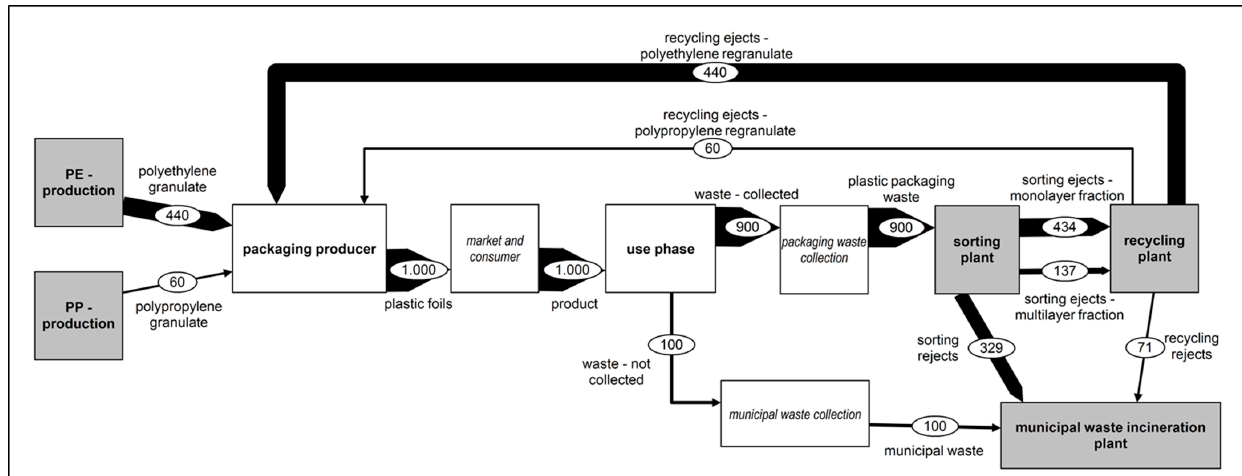
Figure A5. Material flows—Scenario 4—Closed Material Cycle.